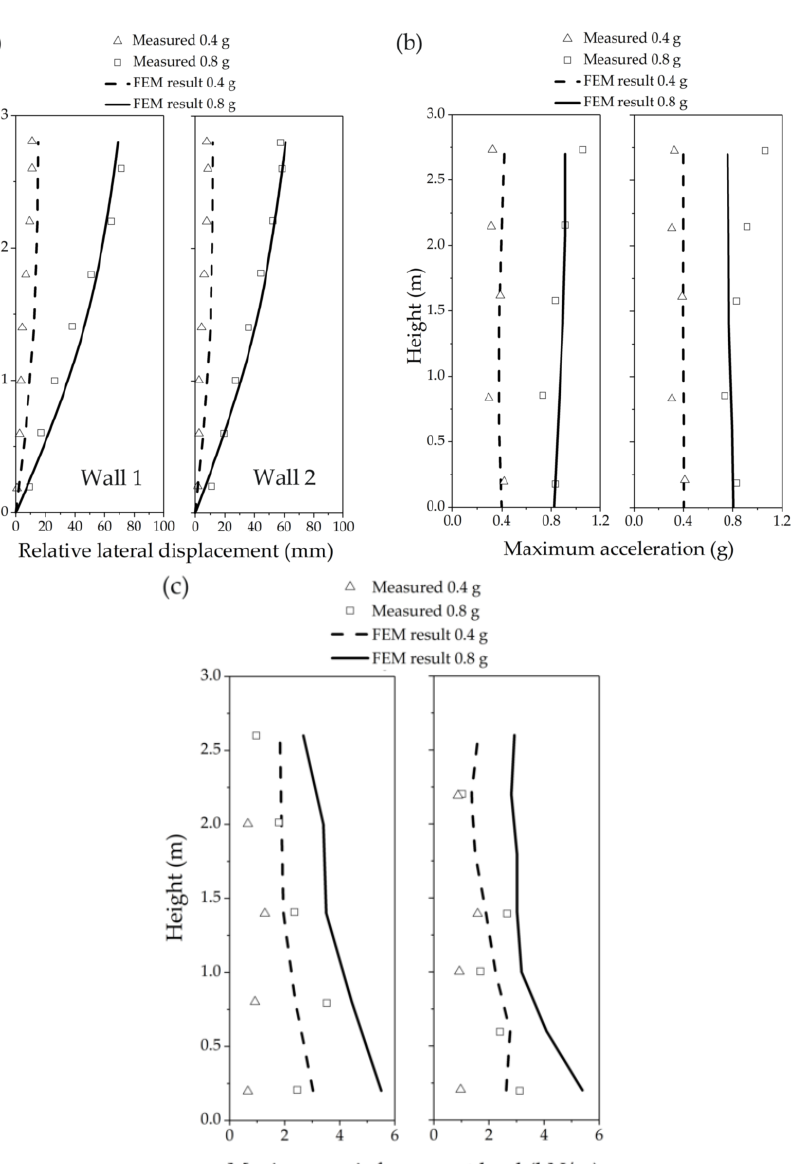
Figure 8. Comparison of the calculated and measured values: ( a ) relative lateral facing displacement; ( b ) maximum acceleration; ( c ) maximum reinforcement load.